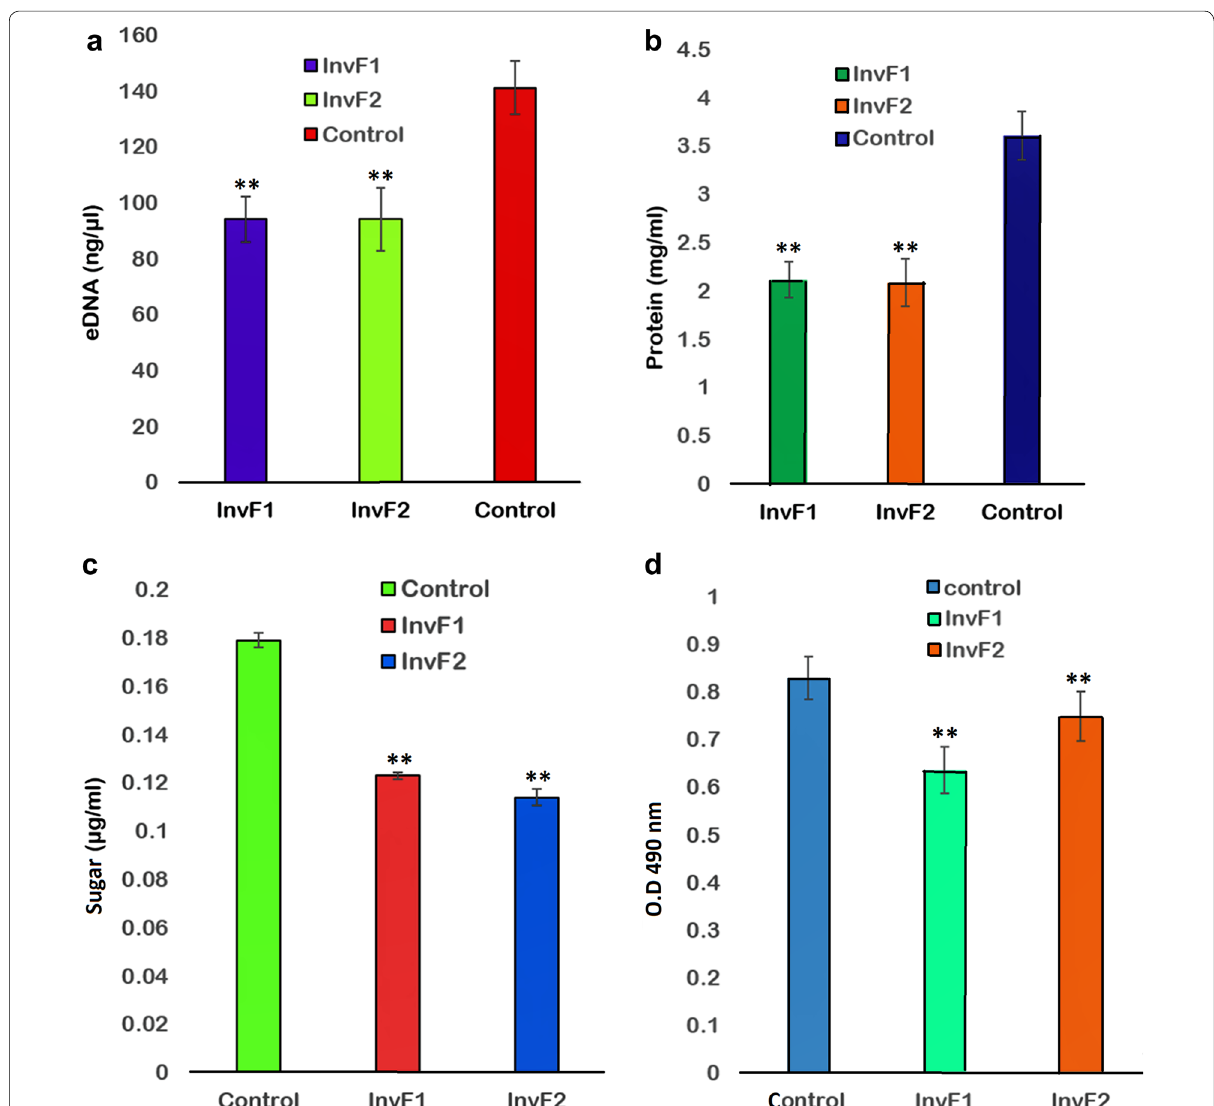
Fig. 4 a eDNA estimation. b EPS protein estimation, c EPS sugar content estimation. d XTT reduction in cell viability assay. The bol -KD InvF1 cells showed 76.7% viability while the InvF2 cells showed 92% cell viability as compared to the control